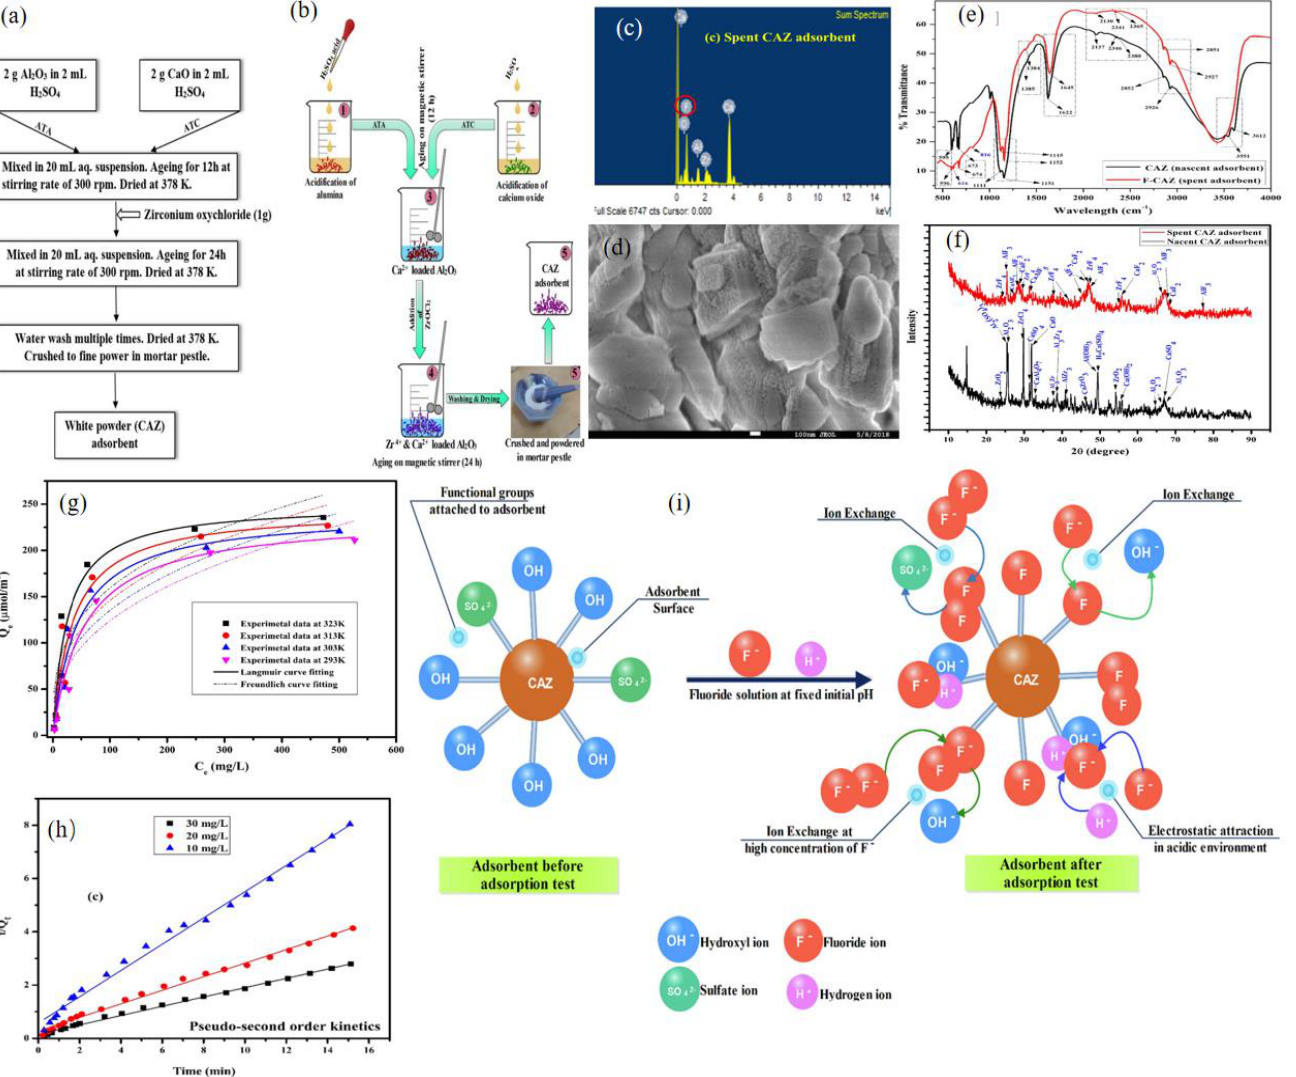
Figure 1. Adsorption of fluoride by CAZ. ( a , b ) Flow diagram of the preparation of CAZ; ( c , d ) the SEM−EDS result of CAZ after the adsorption of fluoride by CAZ; ( e ) FI−IR result of CAZ; ( f ) XRD result of CAZ; ( g ) adsorption isotherm of fluorine by CAZ; ( h ) adsorption kinetics of fluorine by CAZ; and ( i ) adsorption mechanism of fluoride by CAZ [40].